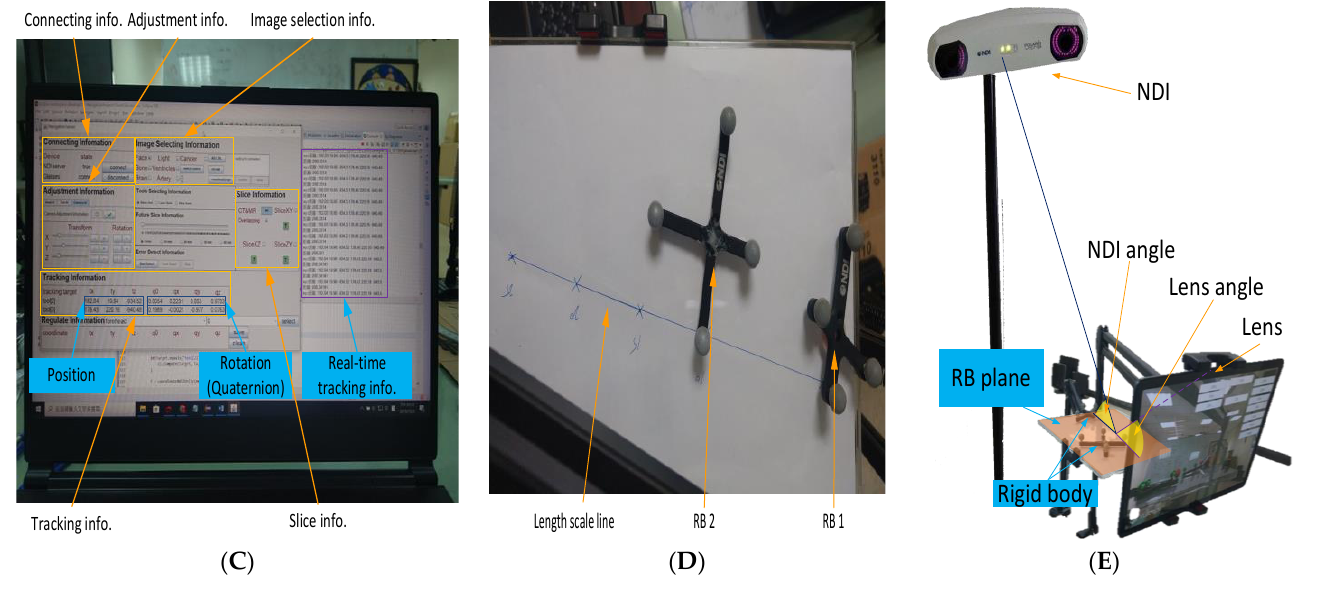
Figure 3. AR superimposition accuracy test. ( A ) Overall hardware implementation. ( B ) Tablet display. ( C ) Server interface. ( D ) Different placement of RBs. ( E ) NDI and lens angles.